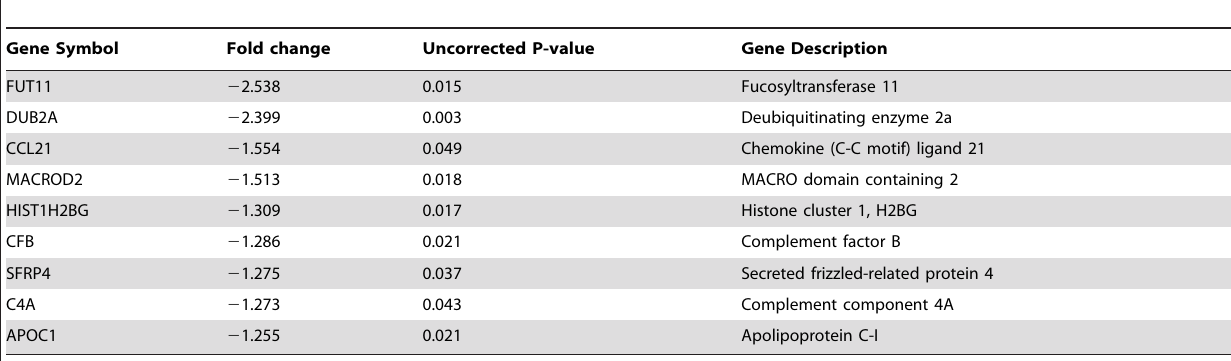
Table 2. Intranasal administration of E-selectin down-regulated mRNA expression of 9 genes in the aorta of ApoE 2 / 2 mice.